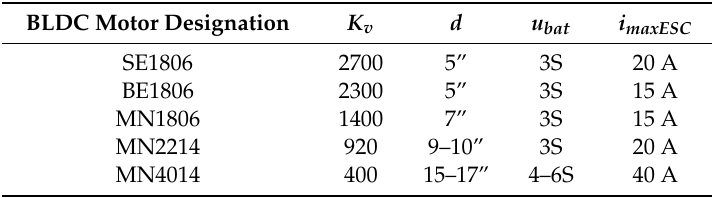
Table 1. Considered EPU setups for selected brushless DC (BLDC) motors.